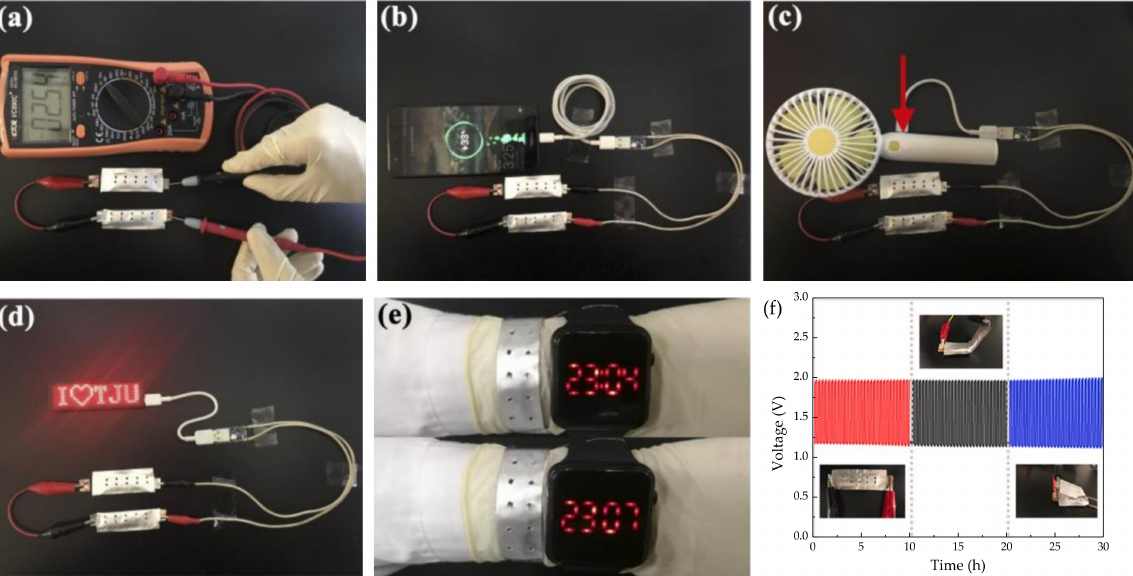
Figure 14. ( a ) Open circuit potential demonstration with two ZABs in series. A demonstration of ( b ) a mobile phone, ( c ) a handheld electric fan, and ( d ) an LED screen powered by two ZAB sets. ( e ) Photographs of an LED watch powered by a fabricated bracelet-type ZAB. ( f ) GCD curves of the ZAB under different bending conditions with corresponding photographs. Reproduced with permission from Nano Energy, 56, Fan et al., Porous nanocomposite gel polymer electrolyte with high ionic conductivity and superior electrolyte retention capability for long-cycle-life flexible zinc–air batteries, 454–462, 2019